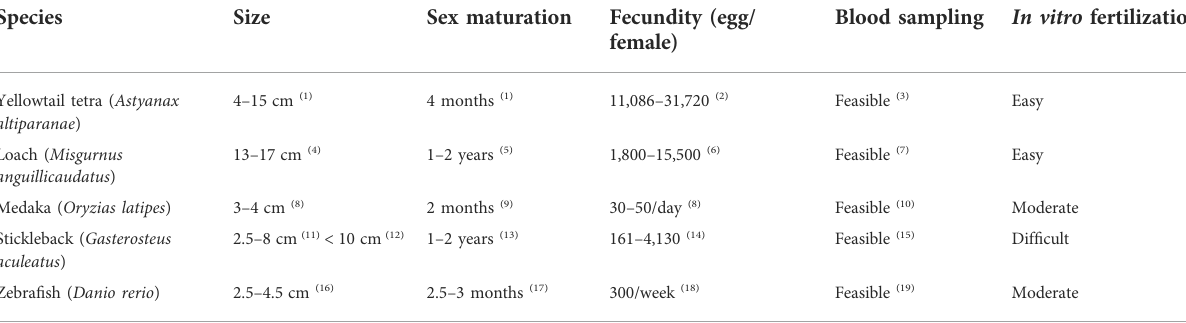
TABLE 1 Biological characteristics of some model fi sh species.